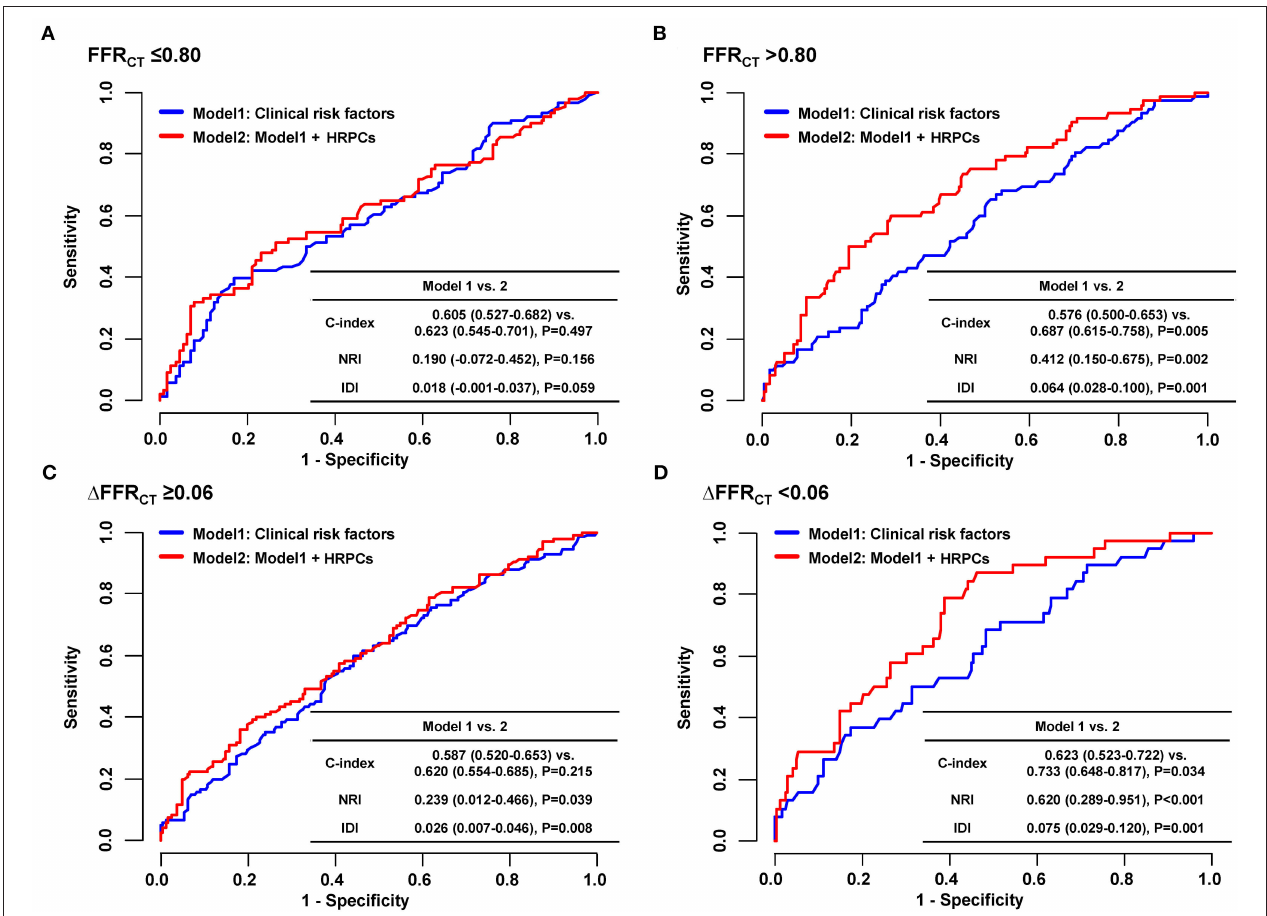
FIGURE 6 | Incremental prognostic value of HRPCs for subsequent coronary events according to hemodynamic parameters. To assess incremental discriminatory and reclassification abilities of HRPCs in addition to clinical risk factors for subsequent coronary events, two models were constructed as follows: model 1: clinical risk factors (age, sex, hypertension, diabetes mellitus, dyslipidemia, chronic kidney disease, and current smoker) and model 2: clinical risk factors + HRPCs (low attenuation plaque, positive remodeling, napkin-ring sign, spotty calcification, minimal luminal area < 4 mm 2 , or plaque burden ≥ 70%). Incremental discriminatory and reclassification abilities of HRPCs were evaluated in vessels with (A) FFR CT ≤ 0.80 , (B) FFR CT > 0.80, (C) 1 FFR CT ≥ 0.06, and (D) 1 FFR CT < 0.06. FFR CT , fractional flow reserve by coronary computed tomography angiography; HRPCs, high-risk plaque characteristics; IDI, relative integrated discrimination improvement; NRI, category-free net reclassification